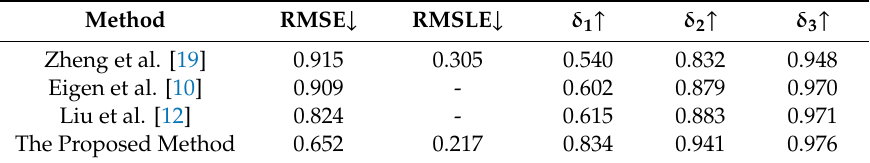
Table 1. Comparison of our method to existing methods on NYU Depth Dataset V2.